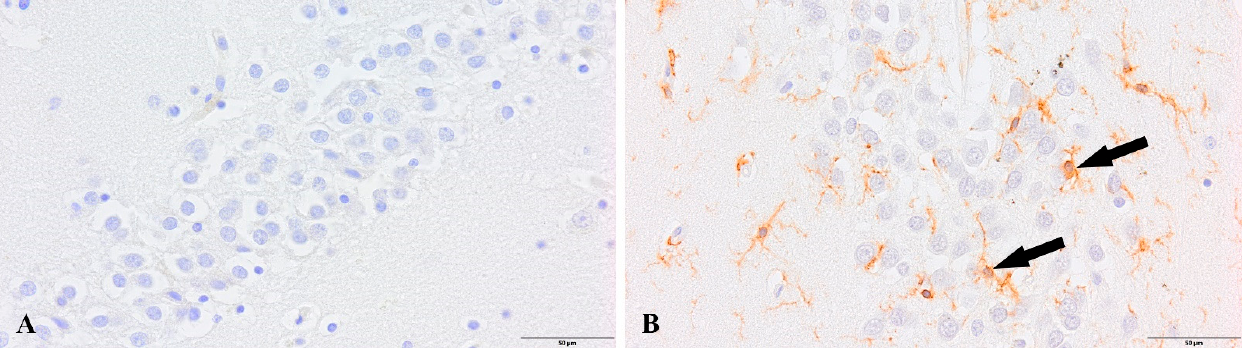
Figure 7. Dentate gyrus. ( A ). Control group. ( B ). Active ramified microglia (arrows). Group patients with diagnosed COVID-19. Immunolabeling LCA antibody.